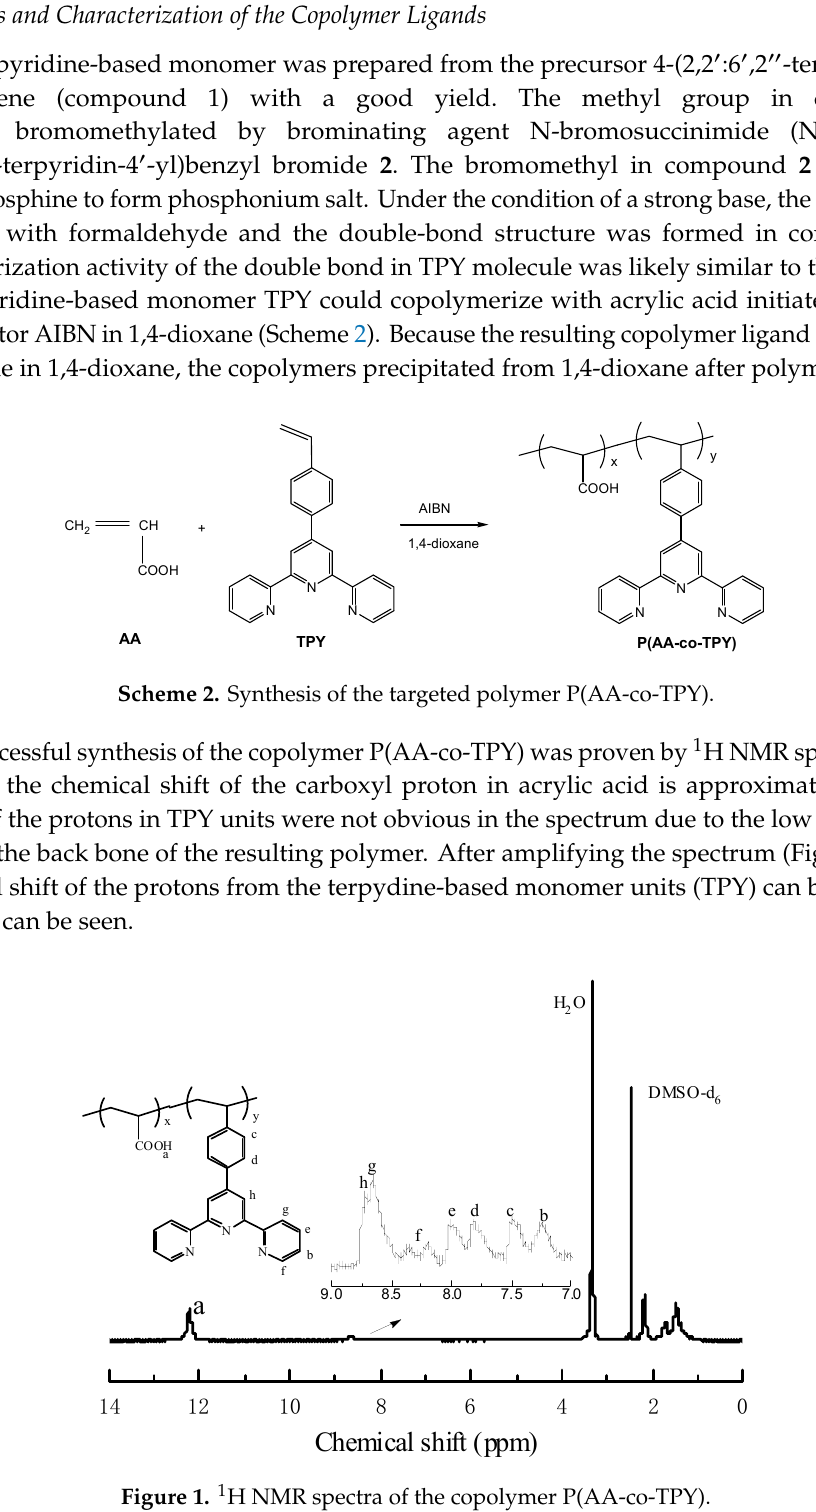
Figure 2. IR spectra of the copolymer P(AA-co-TPY). 3.2. UV-Visible Properties of the Dilute Copolymer Solution and the Coordination Interaction with Transition Ions Thanks to the acrylic acid hydrophilic units, which were the main constitution of the back bone structures, the copolymer P(AA-co-TPY) had good solubility in water. The polymer was neutralized with a 10 wt% of sodium hydroxide solution and diluted to a solution with 0.05 wt% concentration. The UV-visible properties of the polymer ligand and the influences resulting from interaction of the different transition metal ions with the polymer ligand were investigated, and the results are described in Figure 3. The polymer ligand P(AA-co-TPY) exhibited a strong absorption peak at 305 nm,